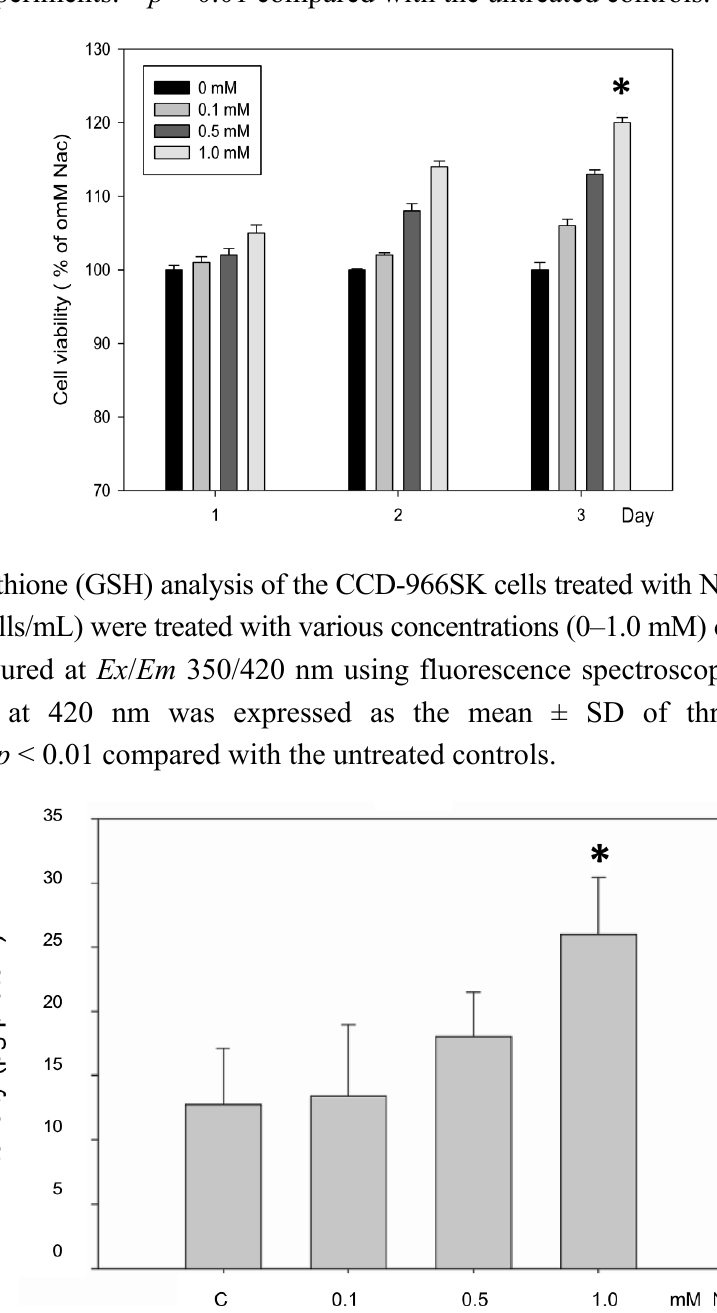
Figure 1. Effect of N -Acetylcysteine (Nac) on the viability of CCD-966SK cells. CCD-966SK cells (1 × 10 4 cells/mL) were treated with various concentrations (0–1.0 mM) of Nac for 1, 2, and 3 days. The viability of the cells was determined by MTT assay. The number of cells that survived was directly proportional to formazan, which was measured spectrophotometrically at 563 nm. Values are expressed as the mean ± SD of three independent experiments. * p < 0.01 compared with the untreated controls.